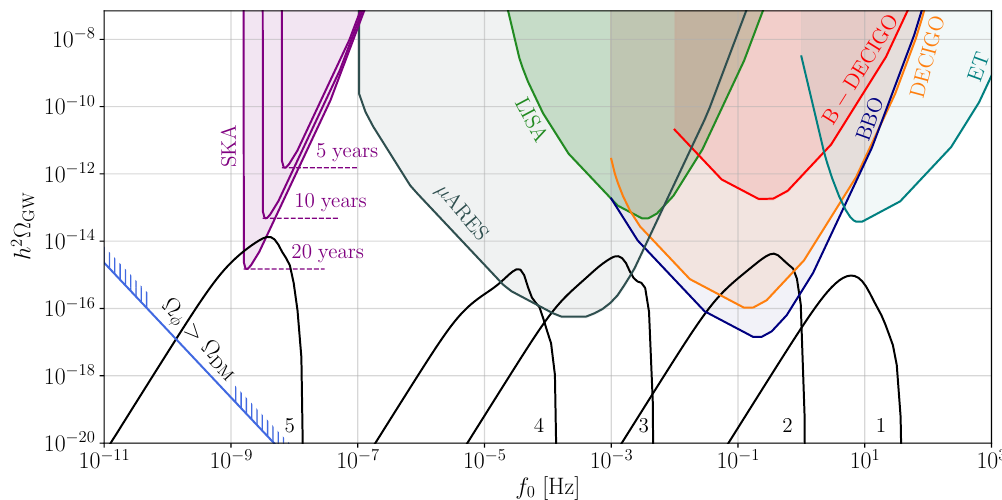
Figure 12: Today’s gravitational wave spectra, calculated with the benchmark param- eters given in Table 2. The coloured regions correspond to the power-law integrated sensitivities of the respective observatories. The blue line corresponds to the estimate from Eq. (73). We find that the axion overcloses the Universe in the entire detectable parameter space.